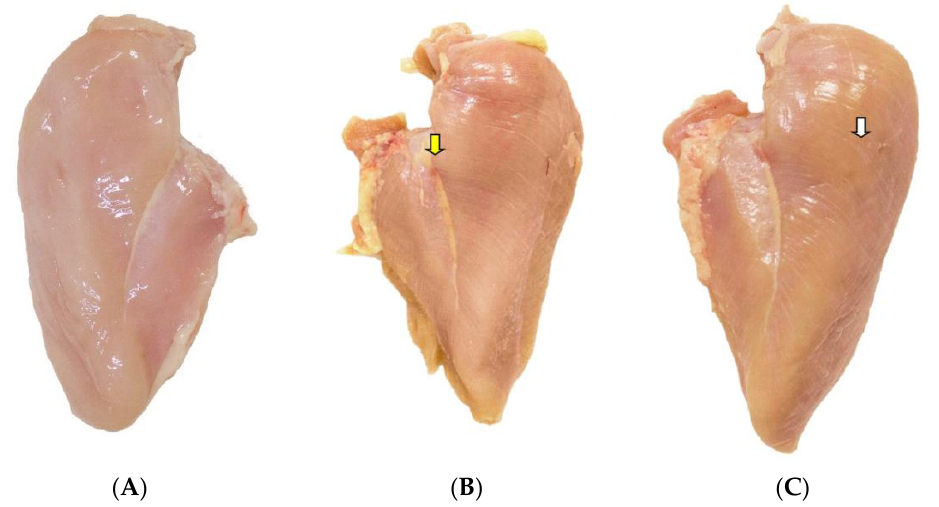
Figure 1. Normal pectoralis major muscle ( A ), and pectoralis major muscle affected by the moderate ( B ) and severe ( C ) degree of wooden breast in Ross chickens (AP 95). There are whitish striations in the upper quadrant of the muscle part (white arrow) as well as reddish (petechiae) and hardened areas in the middle and lower portions of the muscle (yellow arrows).